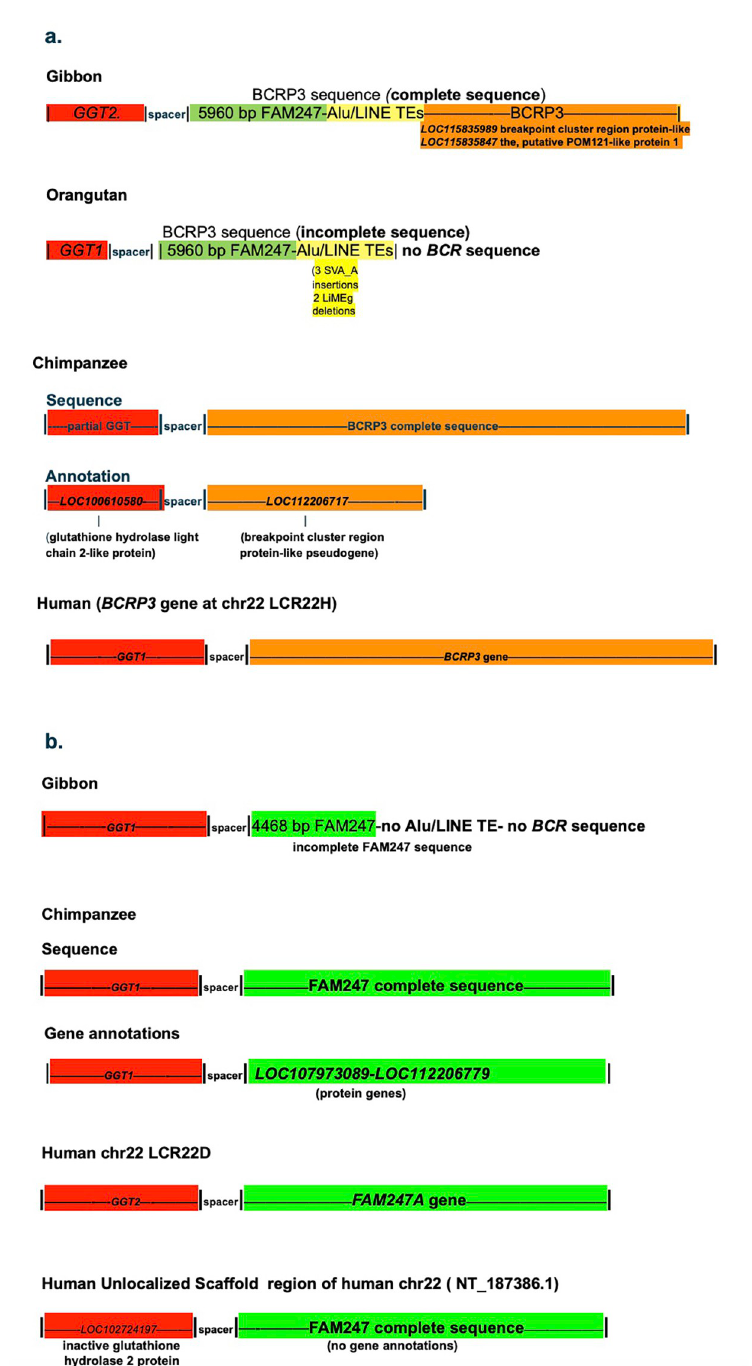
Fig 6. Formation of different sequences and/or genes at spacer 3’ ends sequences from species of the superfamily Hominoidea. a. BCRP3 sequence present at loci that contain a duplication of the GGT-spacer motif showing diverse genes stemming from the BCRP3 sequence. b. The presence of the FAM247 sequence at different GGT-spacer loci in gibbon, chimpanzee and human genomes.